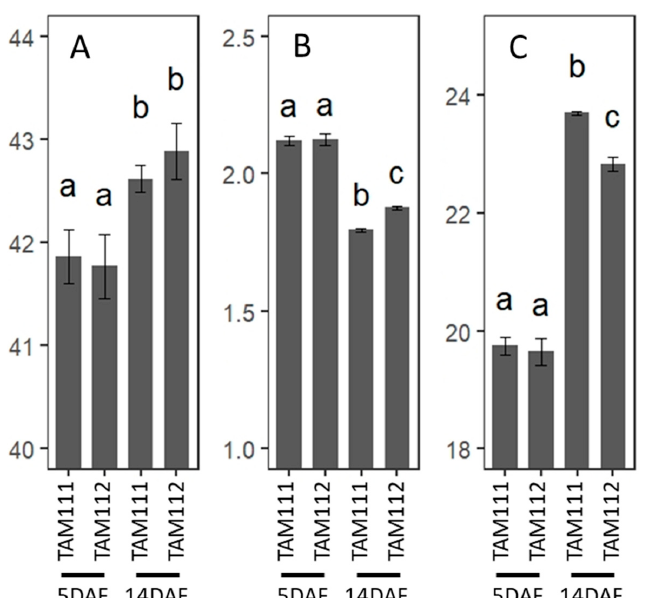
Figure 3. Carbon and nitrogen content of TAM111 and TAM112 grains at 5 and 14 DAF. ( A ) percent carbon, ( B ) percent nitrogen, and ( C ) carbon to nitrogen ratio. Letters indicate significance at α = 0.05 in TukeyHSD-test (n =